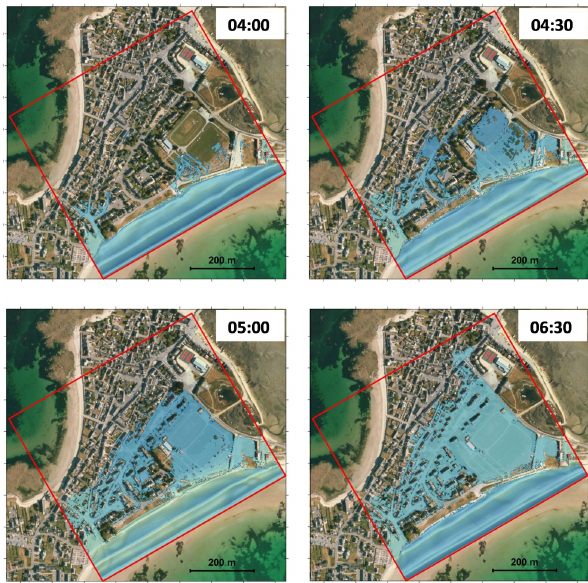
Figure 7. Snapshots of the SURF-WB simulation of overtopping and flooding: Situation at 04:00, 04:30, 05:00 and 06:30 (UTC).